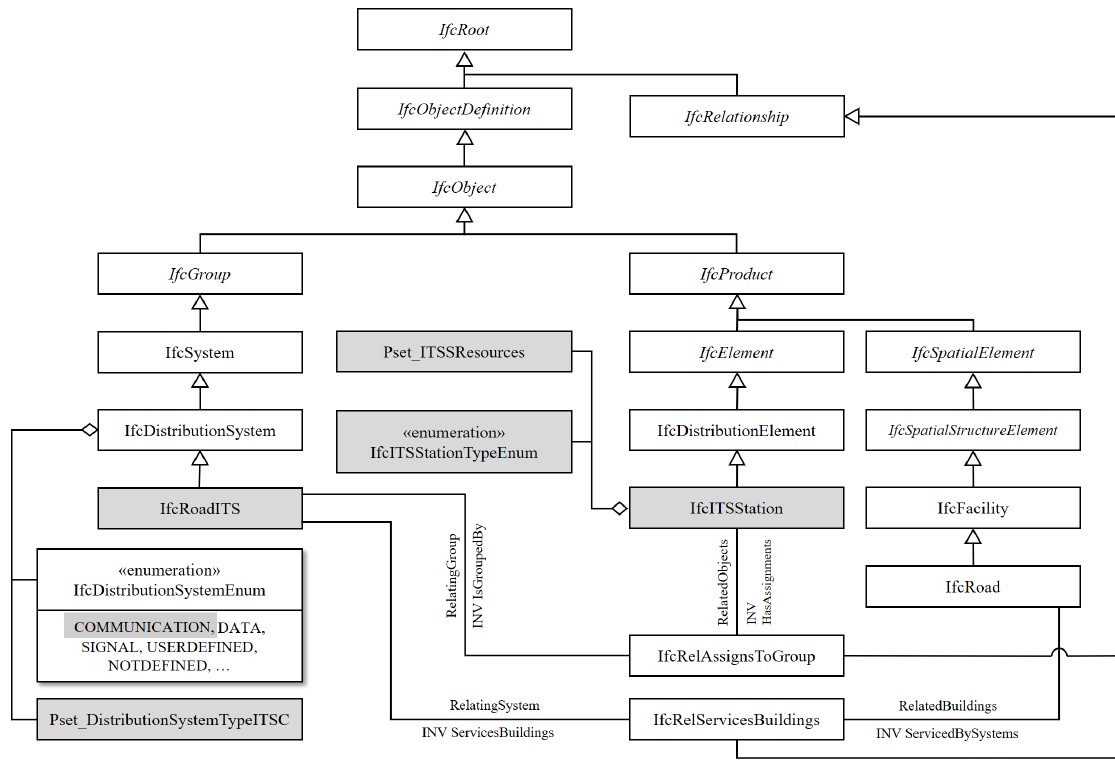
Figure 7. Extract of the IFC schema extension showing entities relevant to ITS in gray